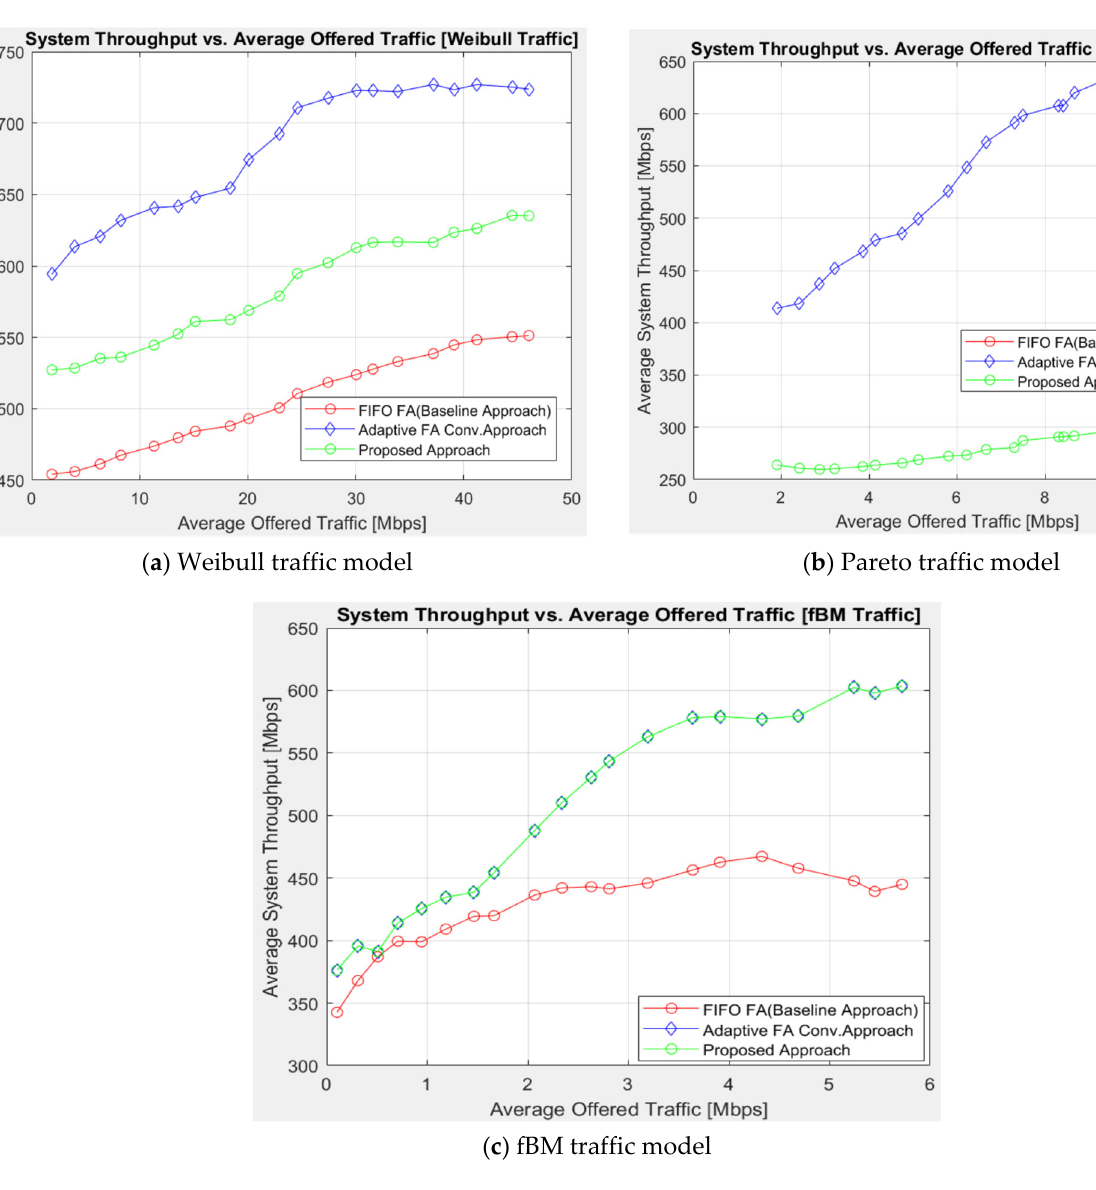
Figure 6. Performance of system throughput versus average offered traffic load when Num STAs = 4 and SNR = 8 dB for the Weibull, Pareto, and fBM traffic models.